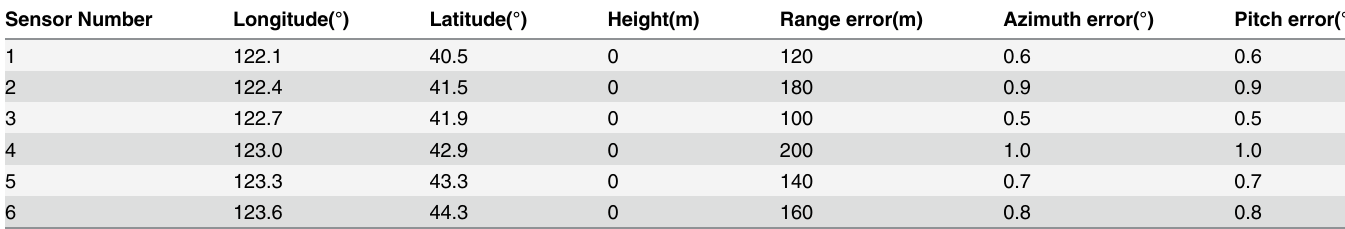
Table 1. The parameters of the